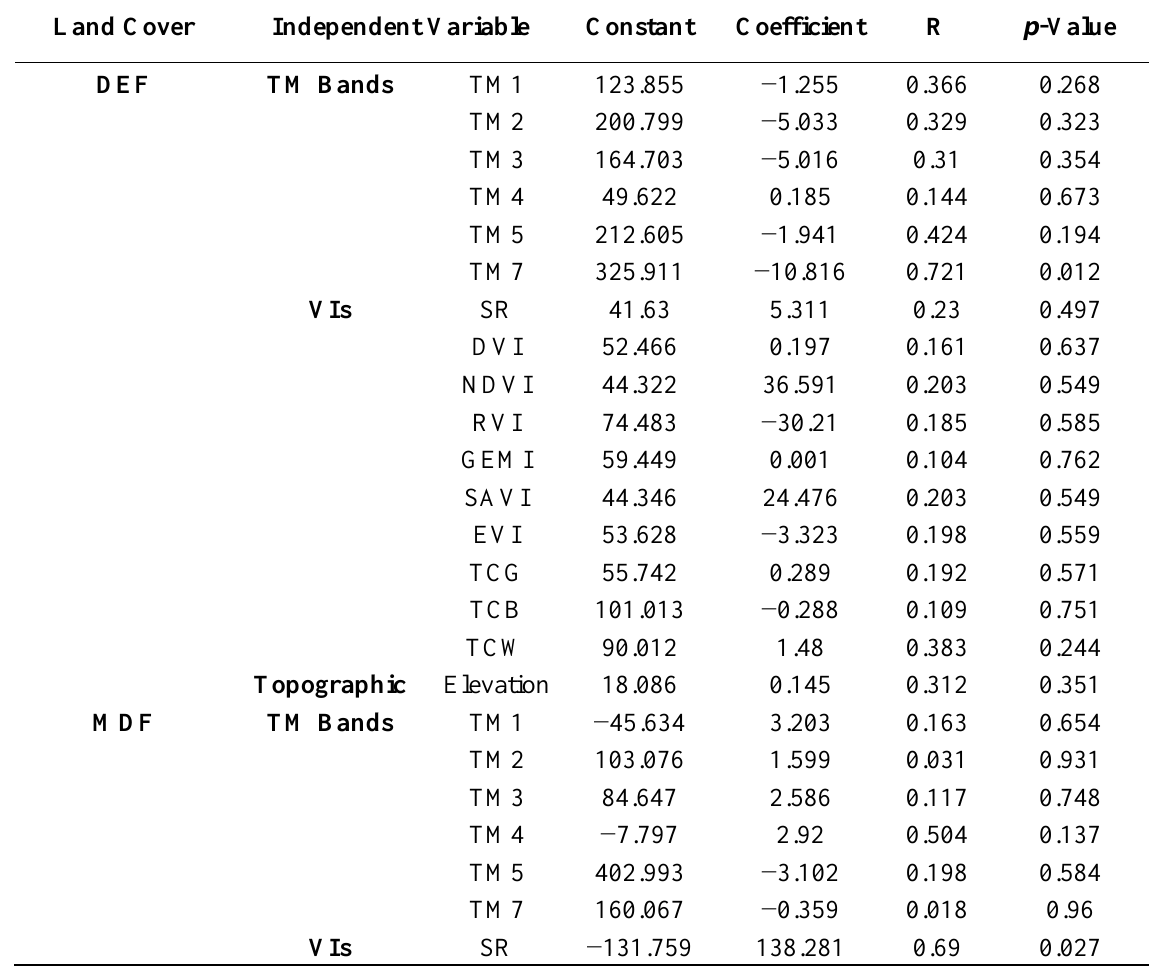
Table A1. Correlation between RS variables and